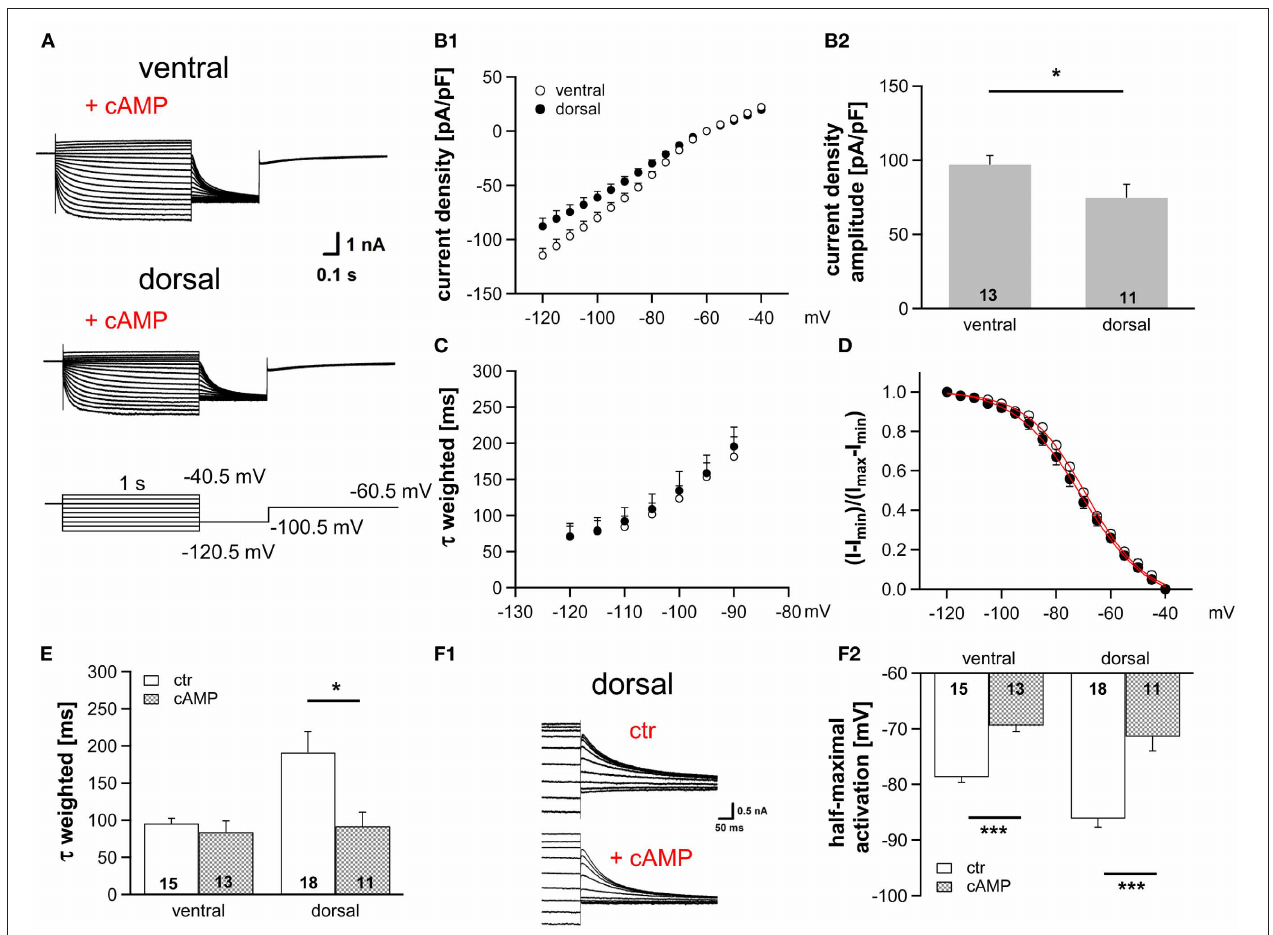
FIGURE 2 | Modulation of I h by cAMP differs along the dorsoventral axis. (A) Current responses to depolarizing and hyperpolarizing voltage steps were recorded from MSO neurons in the ventral and dorsal part of the MSO with 25 μ M cAMP in the pipette solution. (B) I h density gradient persists in the presence of cAMP as illustrated by the current-voltage relationships for ventral ( n = 13) and dorsal ( n = 11) neurons (B1) and their I h density amplitudes for a − 110.5mV voltage step (B2) . (C) The weighted activation time constants and (D) , the voltage dependenceof I h activation overlap in the